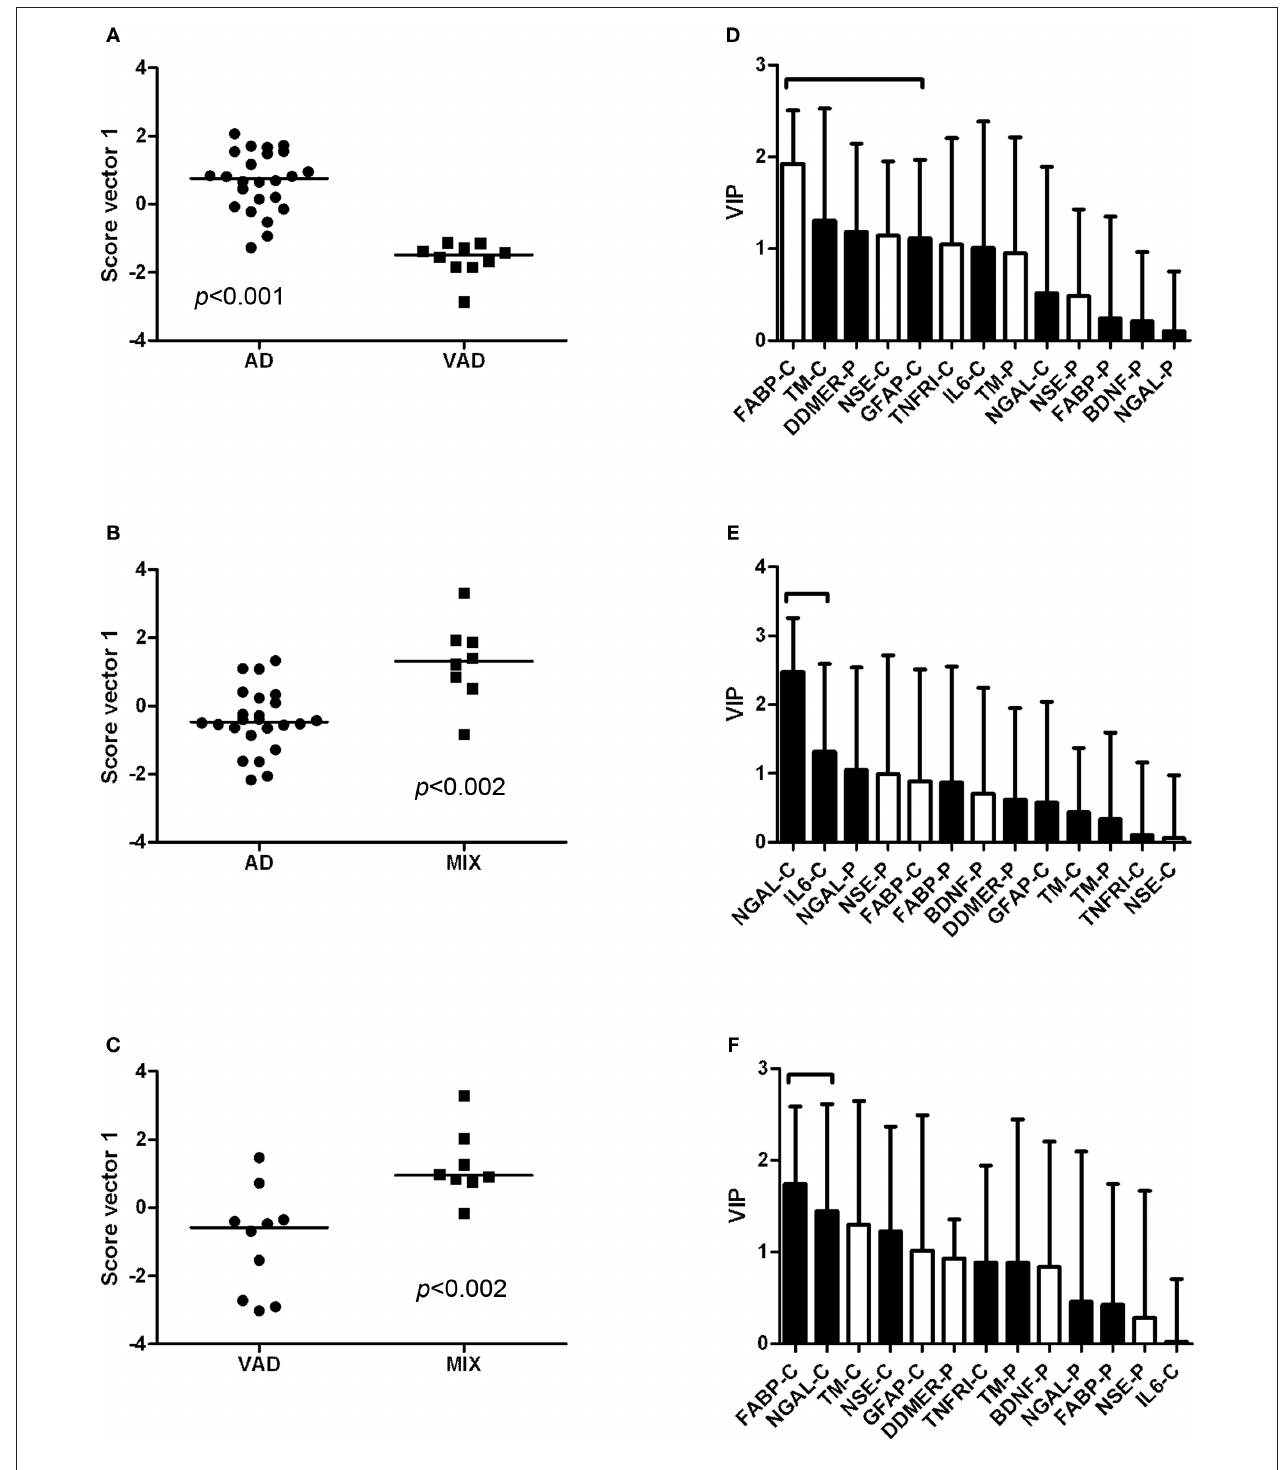
represents an elevated level in the other group. In the lower VIP plot, elevated levels in VAD are represented by white bars and in MIX by black bars. The analytes that contribute significantly to the separation of the diagnostic groups are marked with a